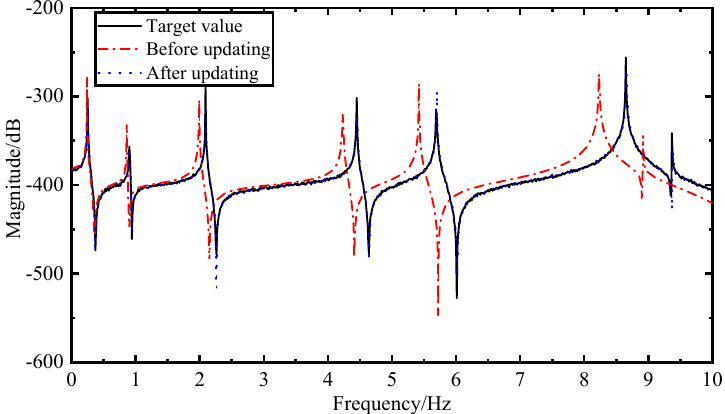
Figure 12. Comparison of FRFs data measured at Node 26 under 5% random white noise.